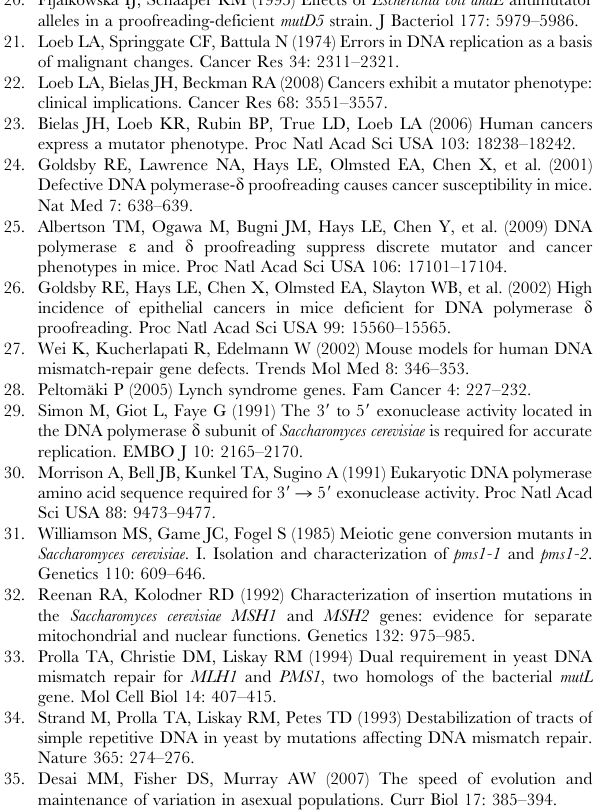
Figure S6 eex amino-acid substitutions in the exonuclease domain of Pol d . The exo domain (red) is shown as a schematic of the a -carbon backbone, and exonuclease active-site residues are gray CPK sticks. Amino acids changed by eex mutations are shown as light blue spheres and labeled to indicate the eex substitutions. The red dotted line corresponds to a missing loop in the structure (amino acids 491–496). The b -hairpin in T4 and RB69 pols affects